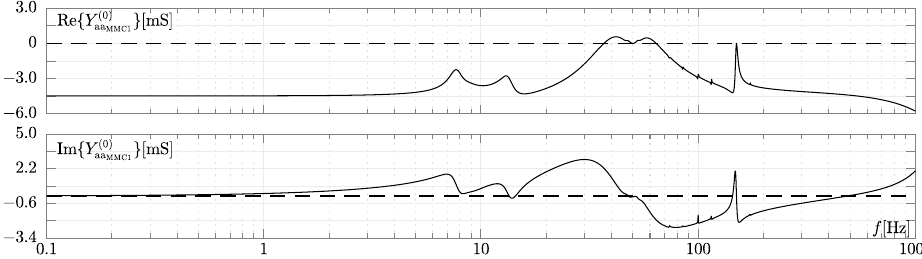
Figure 9. The admittances of the “a” phase of the P / Q type MMC 1 when the accurate MMC model is used. Upper panel: real part of the admittance [mS]. Lower panel: imaginary part [mS]. X-axis: frequency [Hz]. In the panels, the dashed lines denote null real and imaginary parts.